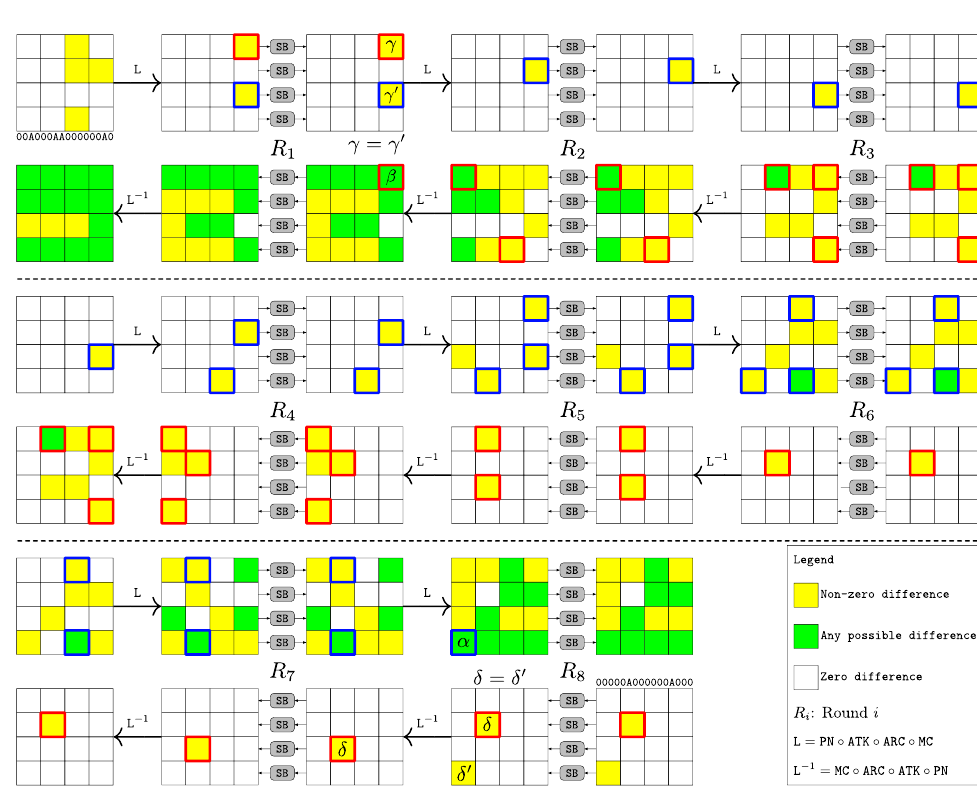
Figure 18: An 8-round boomerang distinguisher for